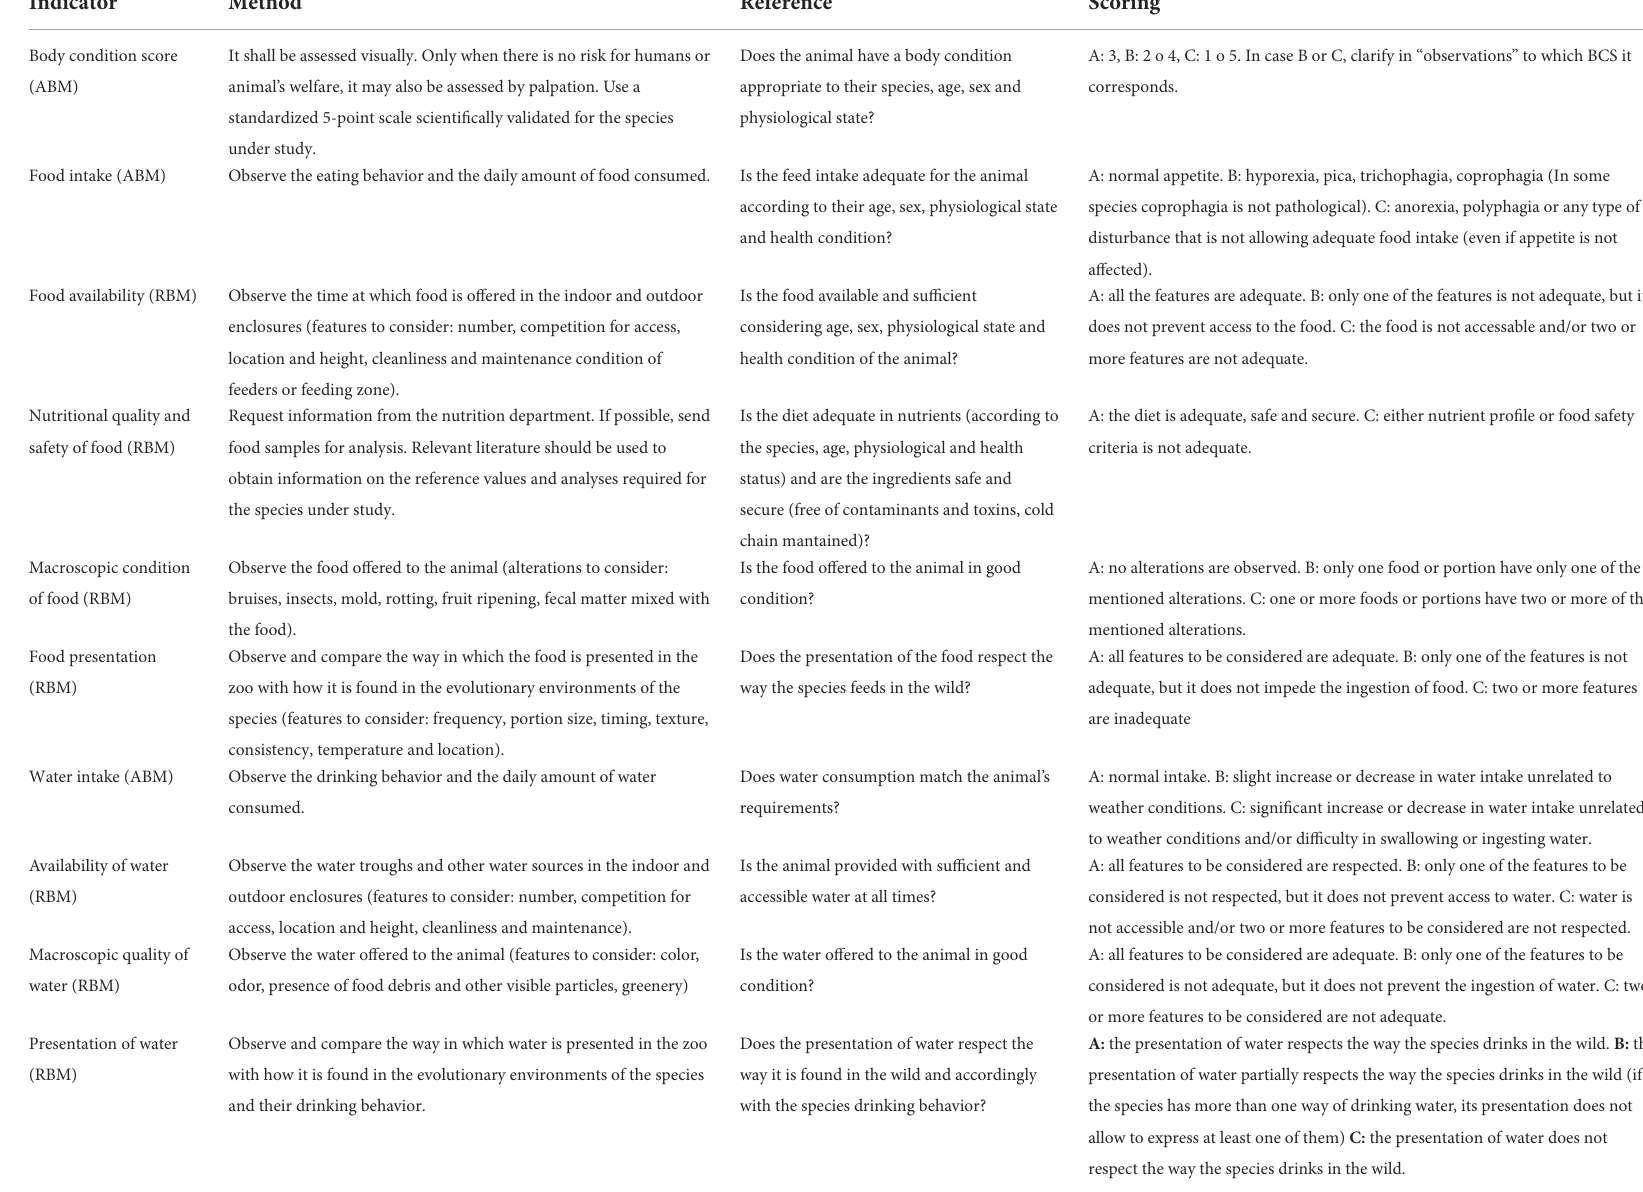
TABLE 5 Summary of the most relevant information that is provided in the user’s manual for assessing nutritional